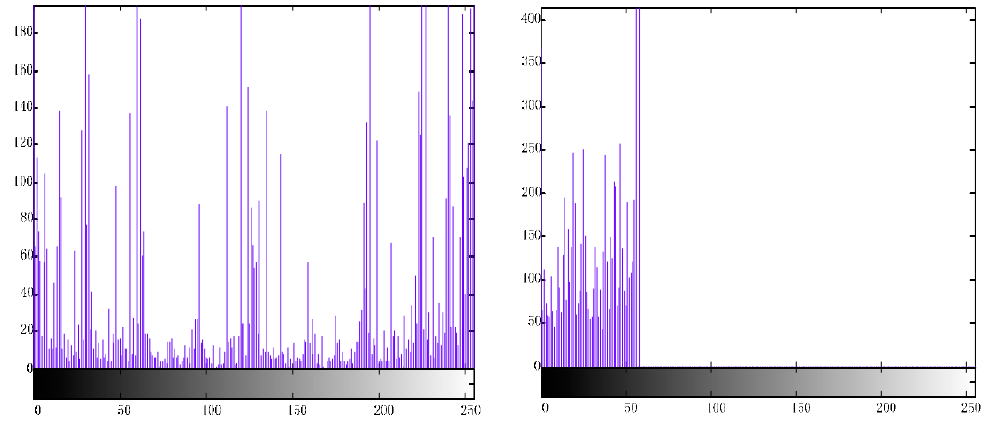
Figure 14. The comparison of the histogram between the original LBP and LBP uniform pattern.